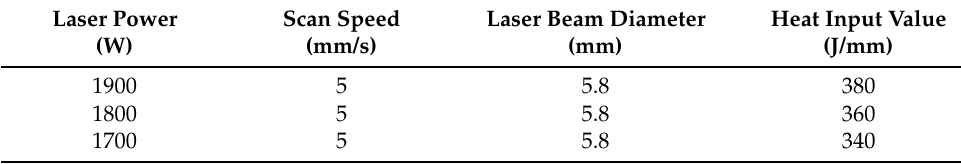
Table 1. Laser parameters of the experiment. Laser